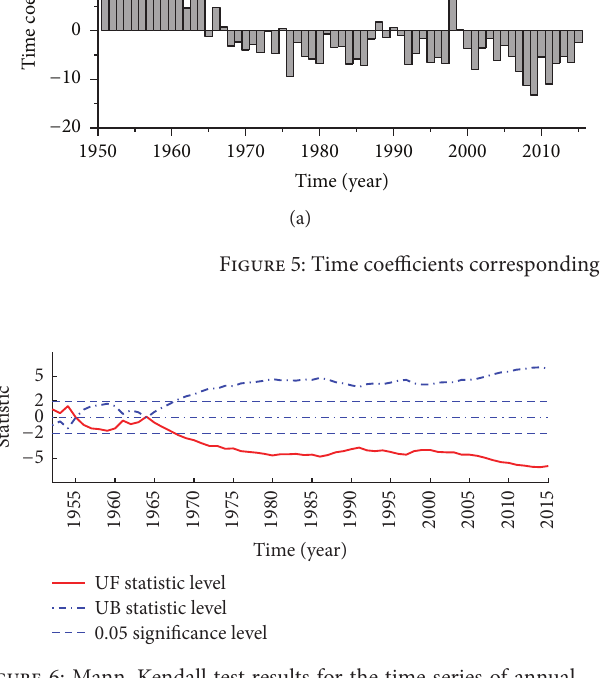
Figure 6: Mann–Kendall test results for the time series of annual average PW in